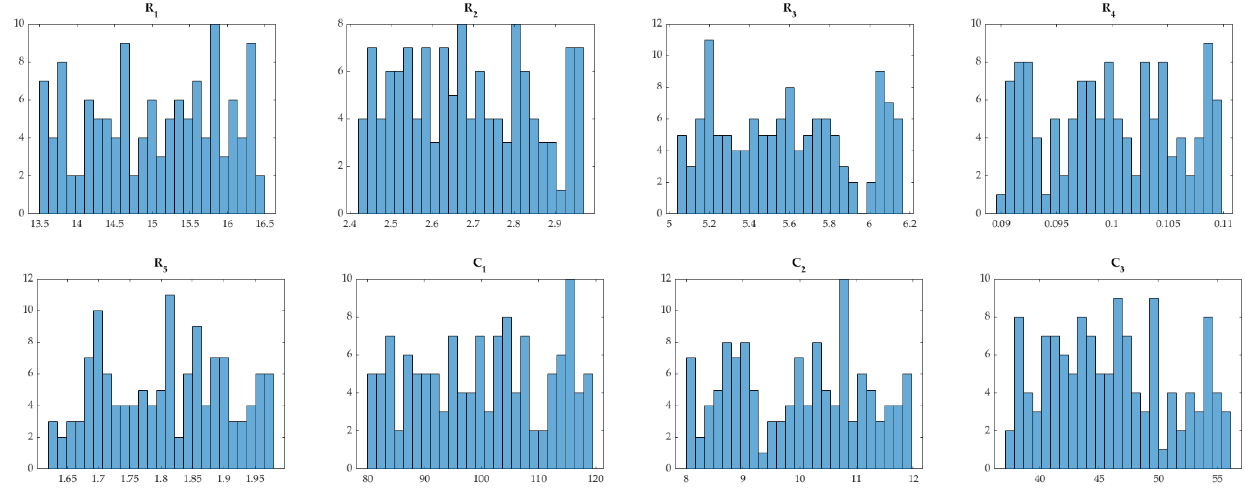
Figure 6. Histograms showing the values employed in the Monte Carlo Analysis (grouped in 25 bins).